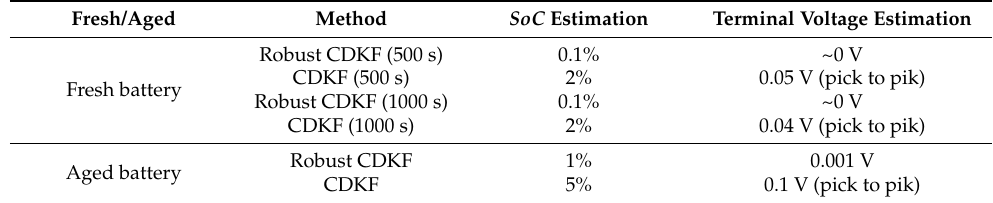
Table 3. Comparison of the SoC estimation errors for Cells #1, 2, and 3.